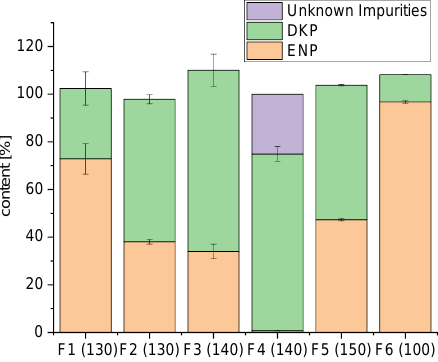
Figure 7. Content uniformity of the extrudates of the screening experiments ( n = 6, mean ± SD).